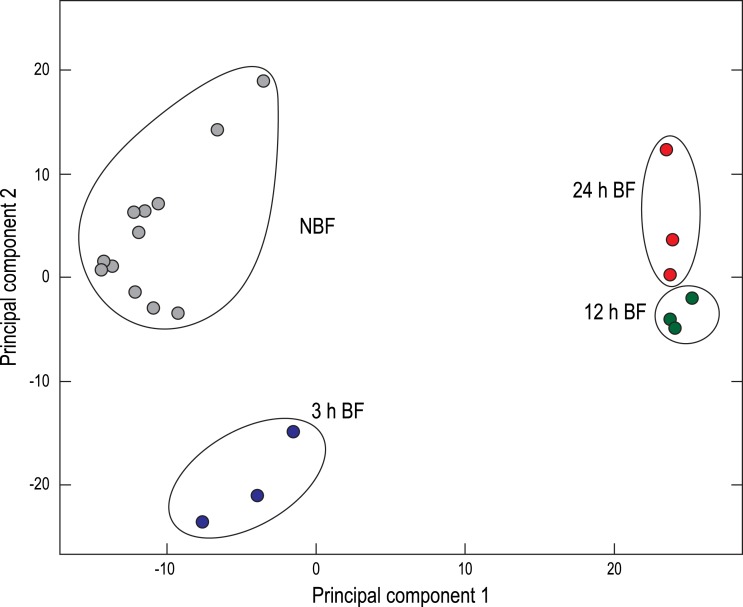
Principal component analysis (PCA) of the paired-end Malpighian tubule cDNA libraries.Each circle represents an individual cDNA library from the indicated treatment. NBF, non-blood-fed; BF, blood-fed.